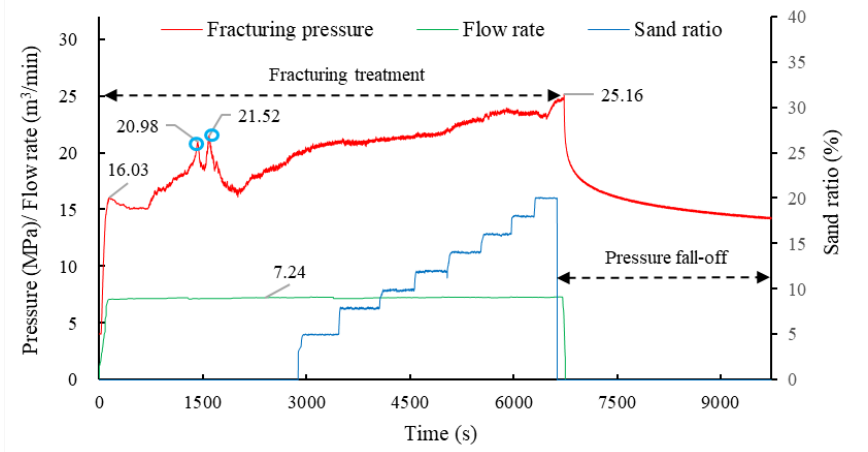
Figure 4. The construction curve of the well.